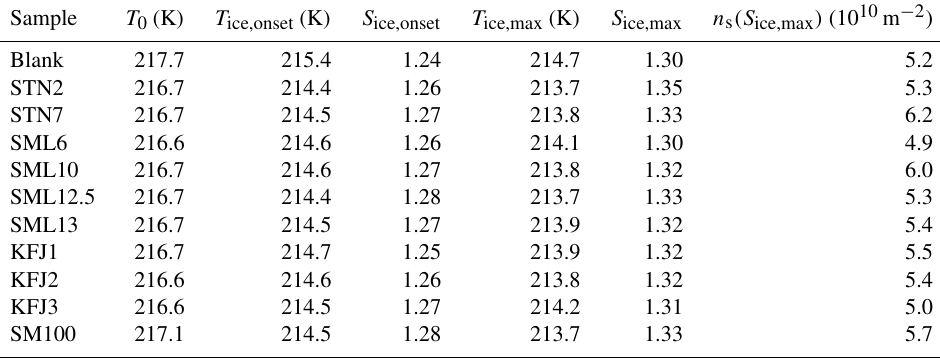
Figure 5. Time series of the AIDA records from the expansion cooling experiments started at 217K for three different samples (a–c) . The sample called “blank” again refers to the commercial bulk Atlantic water sample that has already previously been probed in the AIDA chamber (Wagner et al., 2018). The individual panels show the same data types as in Fig. 3. Table 4. Quantitative analysis of the AIDA expansion cooling runs started at 217K. The sample called “blank” refers to a commercial bulk Atlantic water sample that has previously been probed in the AIDA chamber (Wagner et al., 2018). Due to the similarity of the ice nucleation behaviour between the samples, not all of them were probed at this temperature (no experiment with STN1, KFJ4, KFJ5, and SM100_dil). T 0 : start temperature of the expansion cooling run. T ice,onset : temperature at the onset of ice nucleation (FF = 0 . 1%). S ice,onset : ice saturation ratio at the onset of ice nucleation. T ice,max : temperature when the maximum ice saturation ratio during the expansion run was reached. S ice,max : maximum ice saturation ratio during the expansion run. n s (S ice,max ) : ice nucleation active surface site density evaluated at the maximum ice saturation